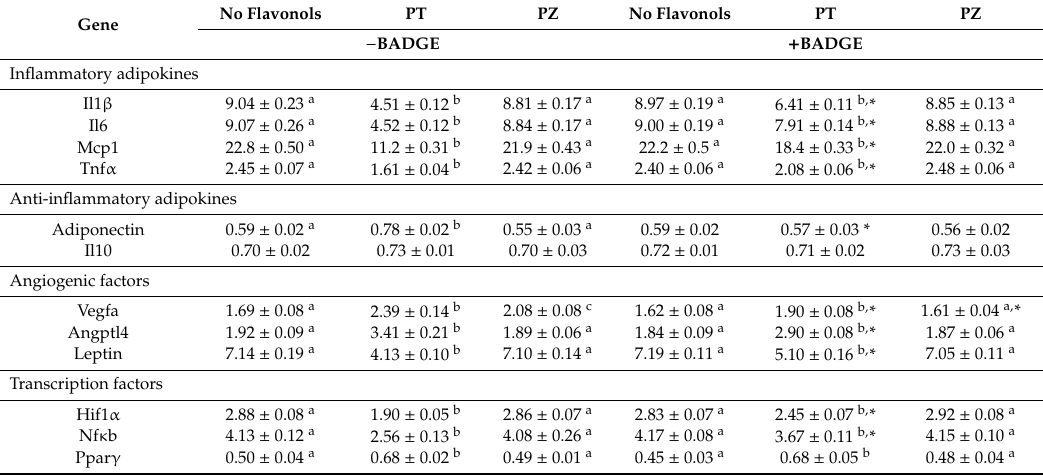
Table 3. mRNA expression in LPS + CoCl 2 -stimulated adipocytes treated with PT or PZ, with and without BADGE 1